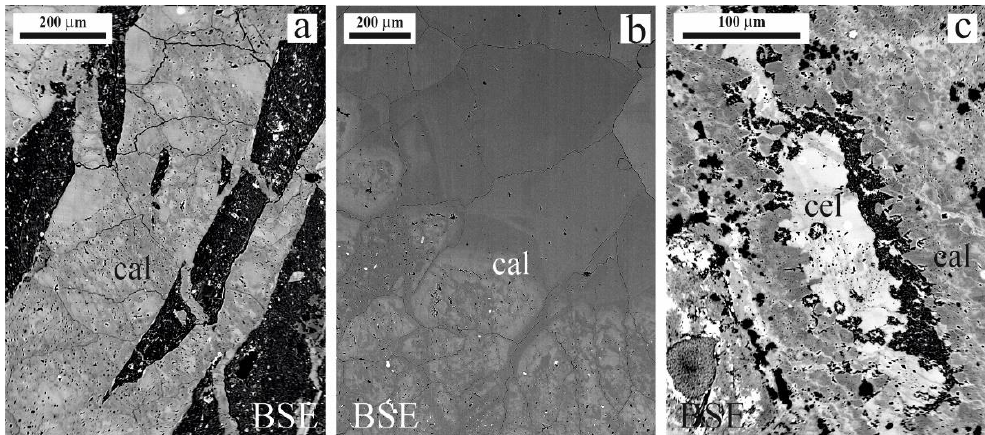
Figure 9. Back-scattered electron (BSE) images of zoned calcite aggregates crystals from “Chilean Manto-type” Cu(-Ag) deposits: ( a , b ) Quebrada Marquesa-La Serena- and ( c ) Melipilla (central Chile).